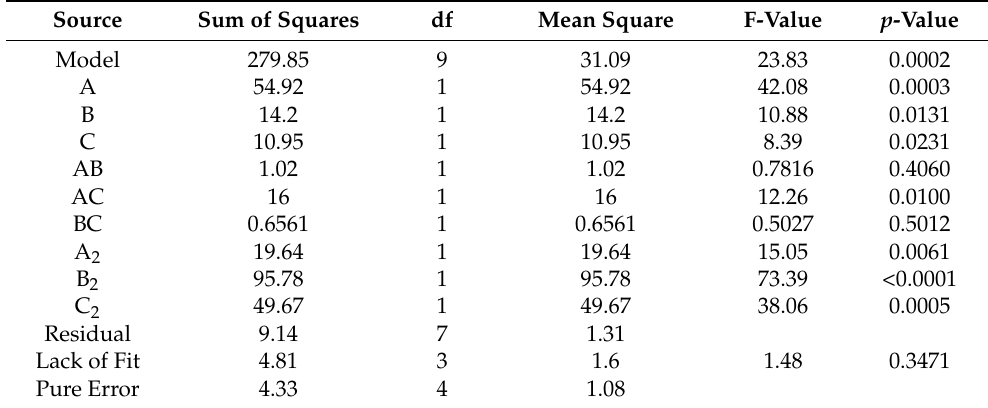
Table 2. ANOVA for response surface quadratic